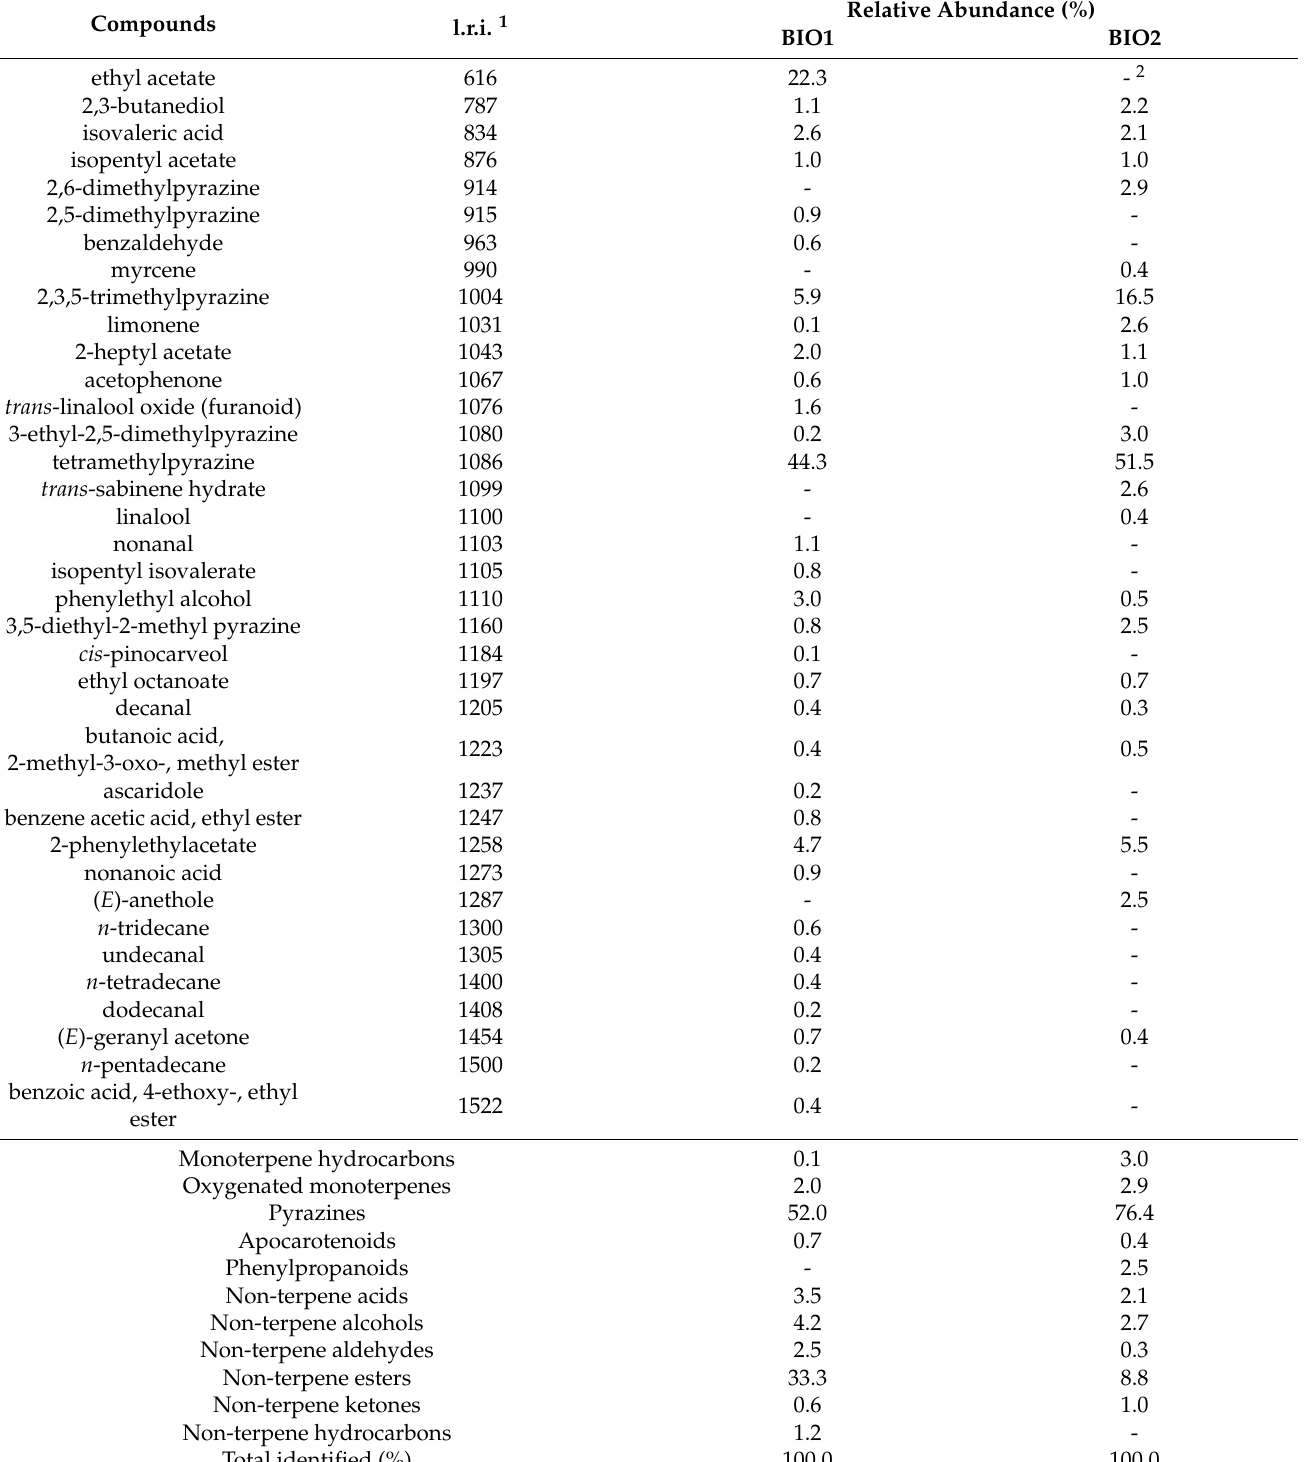
Table 3. Complete compositions of the headspaces sampled for organic dark chocolate bars (BIO1 and BIO2).